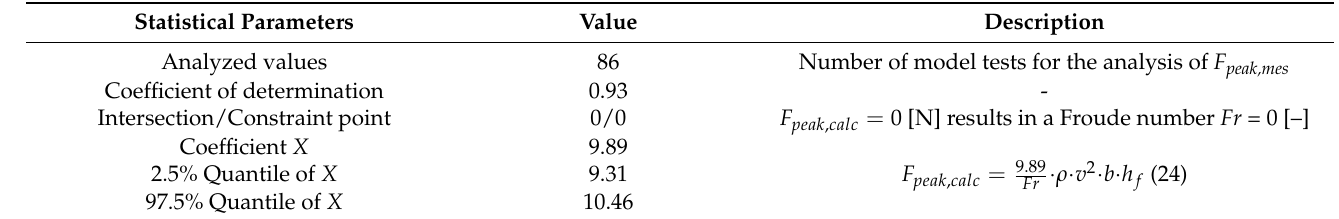
Table 3. Statistical characteristics of linear regression for testing factor α using the 86 experimental results and Equation